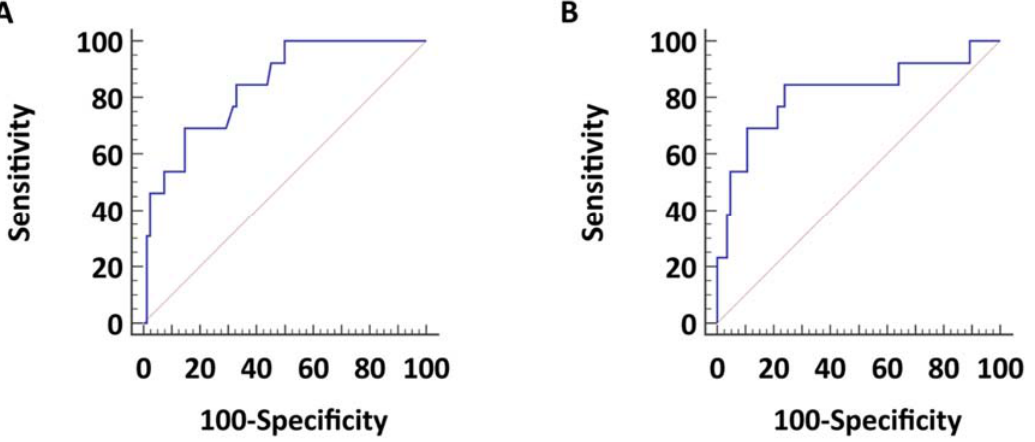
Figure 2. ROC curves for ICOS and ICOS ‐ L. The figures represent the ROC curves for ICOS ( A ) and ICOS ‐ L ( B ) for the identification of